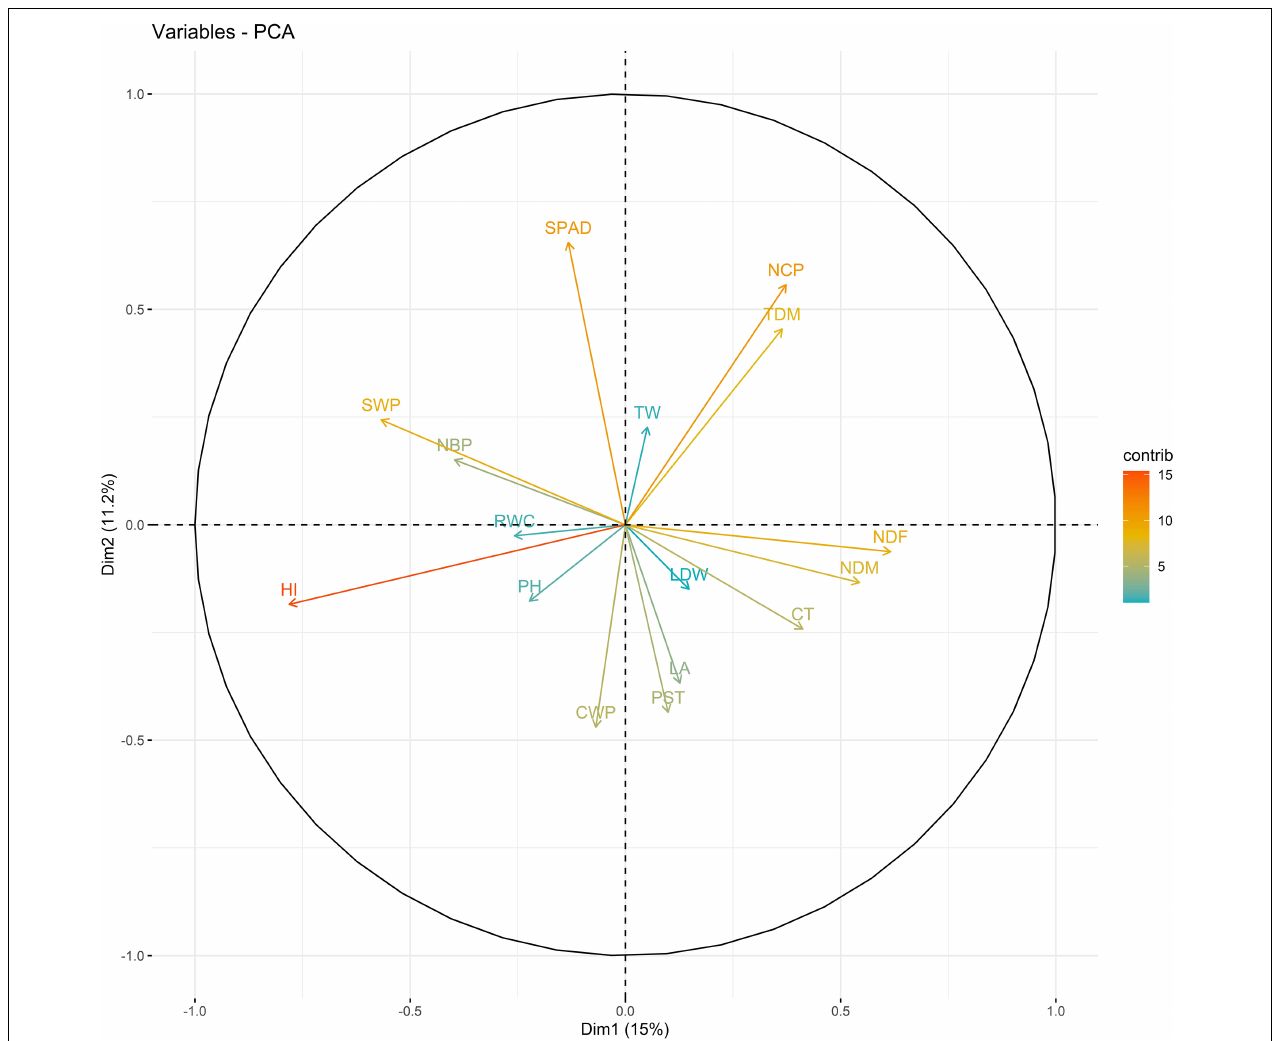
FIGURE 4 | Biplot between PC1 and PC2 showing contribution of various traits during year 2019 season under WS